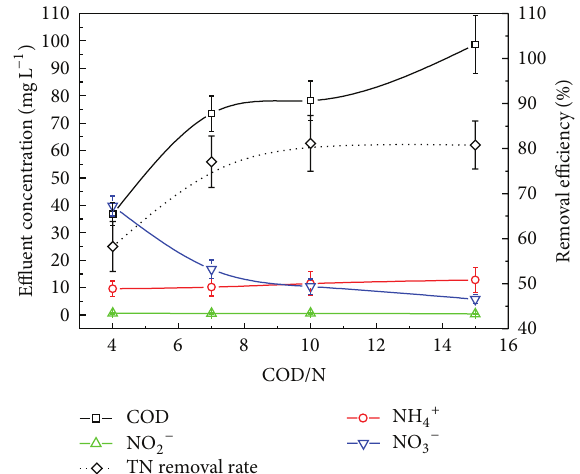
Figure 5: Reactor performance under different